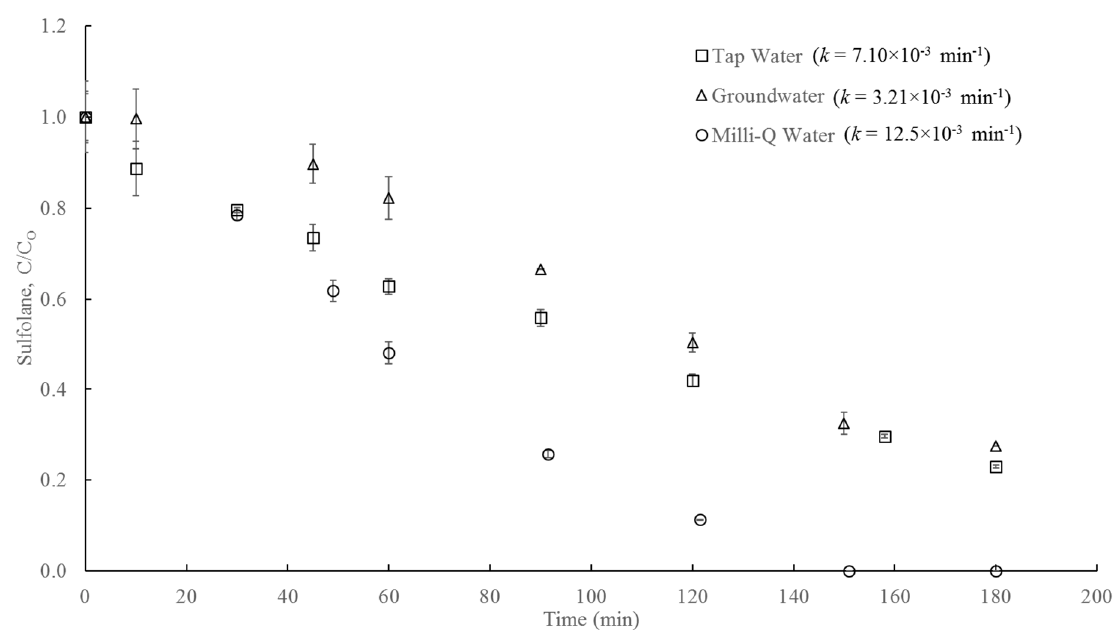
Figure 3. Photocatalytic degradation of sulfolane using 2 g/L of TiO 2 and UVA-LED in milli-Q water, tap water, and